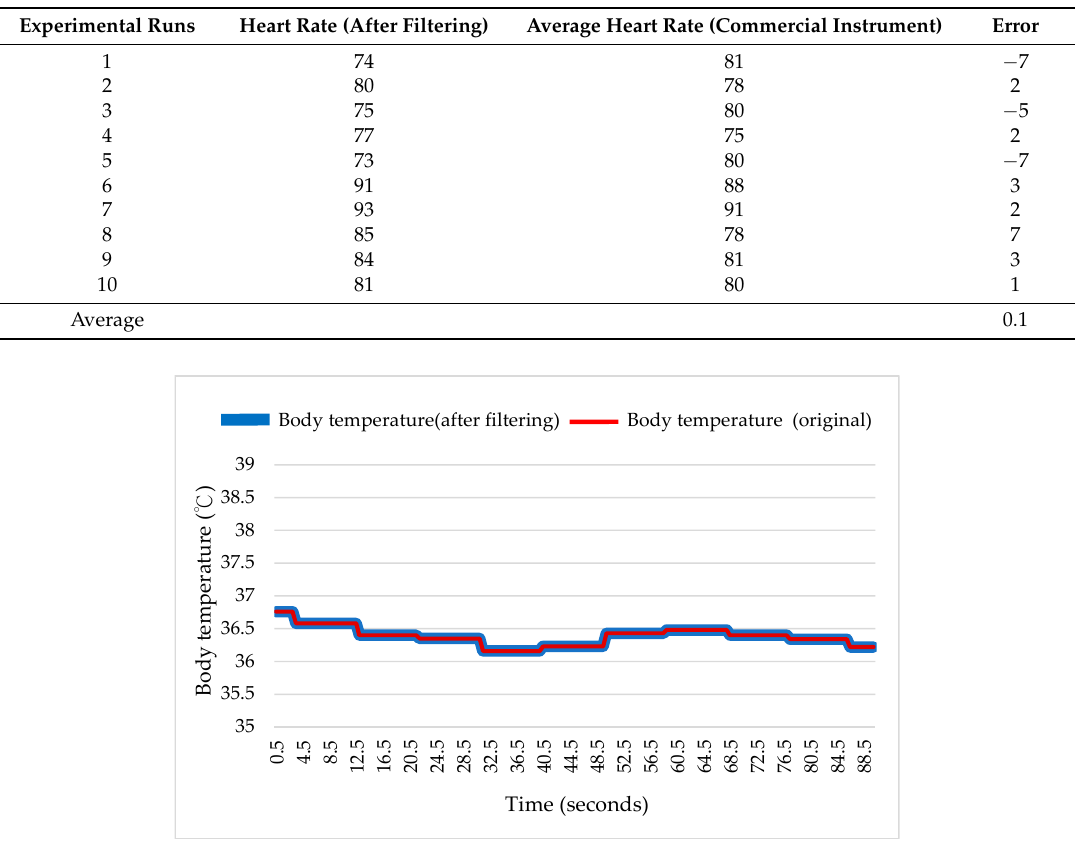
Figure 9. Comparison between the original and filtered body temperature when the user was at rest.